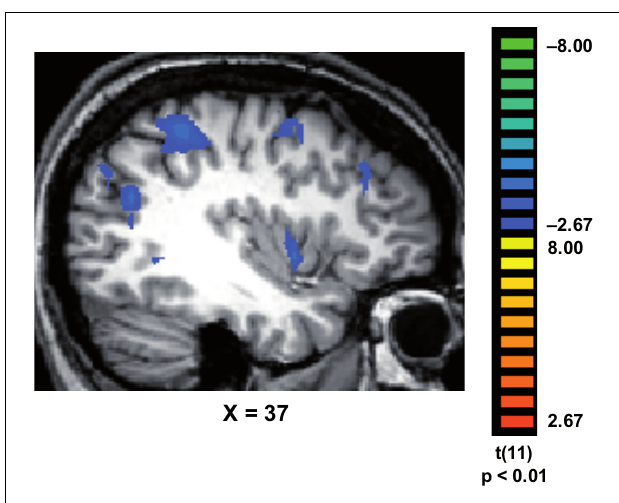
FIGURE 4 | Correlations between response latencies and brain activation. In trained subjects, the slower reaction times recorded during their “No, I did not recognize any familiar objects in the painting” responses, were correlated with activation in a network of regions that included the medial temporal gyrus (MTG); intraparietal sulcus (IPS); medial frontal gyrus (MFG); inferior frontal gyrus (IFG) and insula